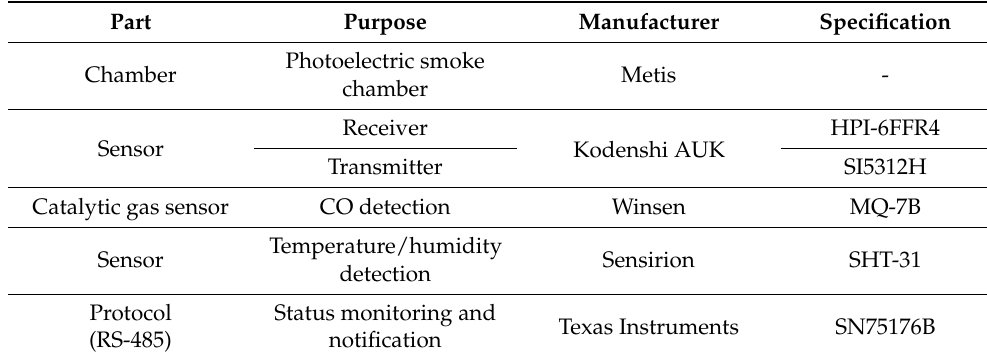
Table 2. List of parts used for